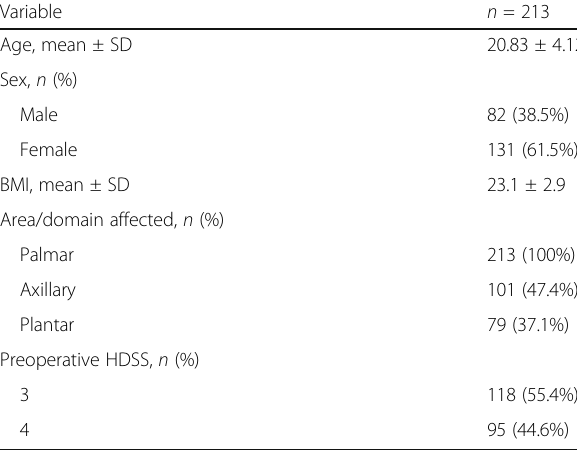
Table 2 Patient preoperative